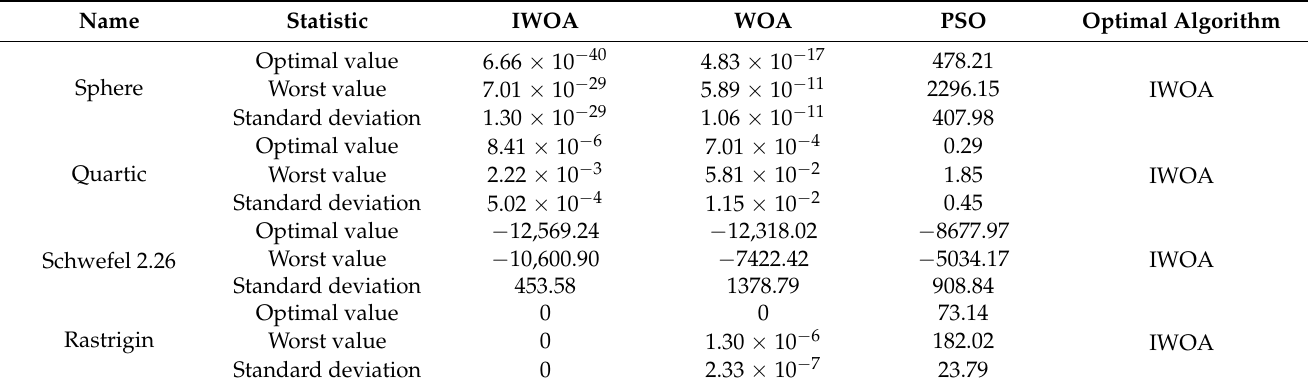
Table 2. The analysis of optimization